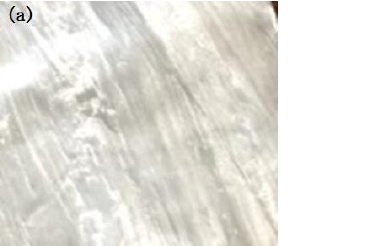
Figure 12. The tensile fracture morphology of sample 3-2 (( a ) aluminum foil; ( b ) DSPE). In Figure 13, there significant residue can be seen on one side of the aluminum foil, as well as some pits and a small amount of aluminum foil residue on the polymer side. This shows that part of the tensile fracture of the interface occurred in the bonding base metal and the bonding strength was high at this time (1.3 MPa). Figure 13. The tensile fracture morphology of sample 3-3: (( a ) aluminum foil; ( b ) DSPE). To a certain extent, a high bonding voltage can tighten the interface and improve the carrier concentration. The peak current in bonding also increases. A higher bonding voltage can improve the efficiency of the bonding reaction, increase the thickness of the bonding layer, and improve the bonding quality. However, when the bonding voltage is too high, the bonding interface has almost no strength because of the bonding failure. 4. Conclusions In this study, the effect of the bonding current on the bonding interface was analyzed from the theoretical derivation, which bears certain significance for enhancing the effi- ciency of anodic bonding encapsulation and improving the connection quality. More im- portantly, this is the first time theoretical analysis has been conducted on the current of the anodic bonding between PEG-based polymer solid electrolyte and metal. Specific con- clusions are thus presented as follows: